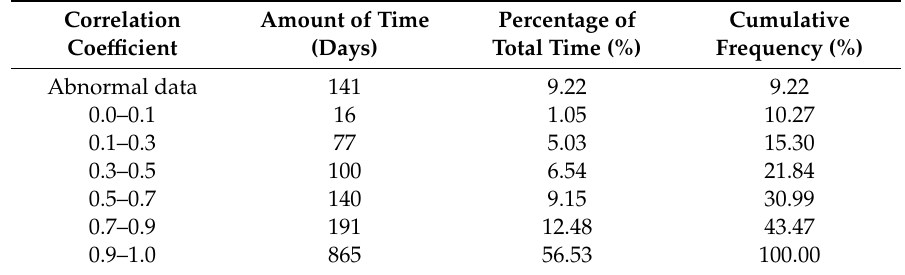
Table 1. Correlation coe ffi cients between the measured precipitation and remote sensing precipitation time series data.